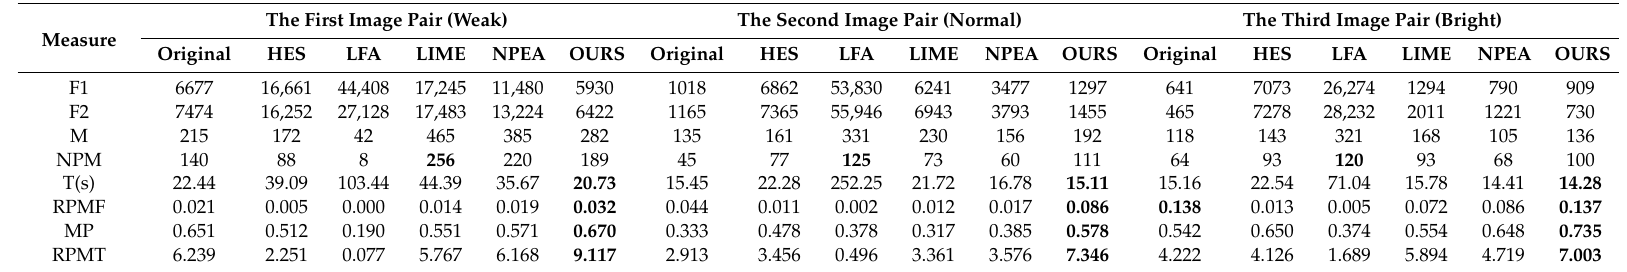
Table 2. Numerical performance indicators of SIFT for the first to third image pairs.